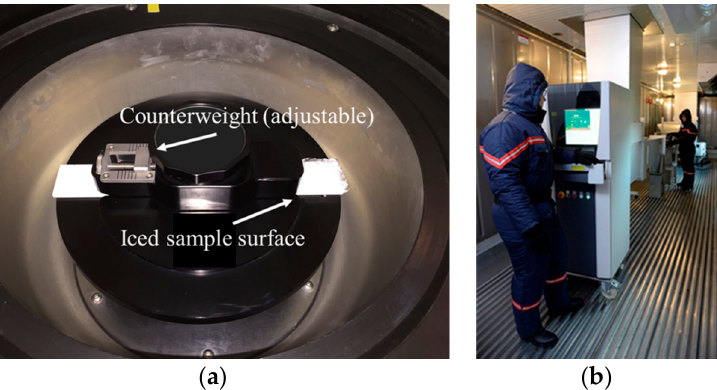
Figure 2. ( a ) View inside the centrifuge with modified rotor and prepared sample; ( b ) ice lab (with ice wind-tunnel) to perform the tests.